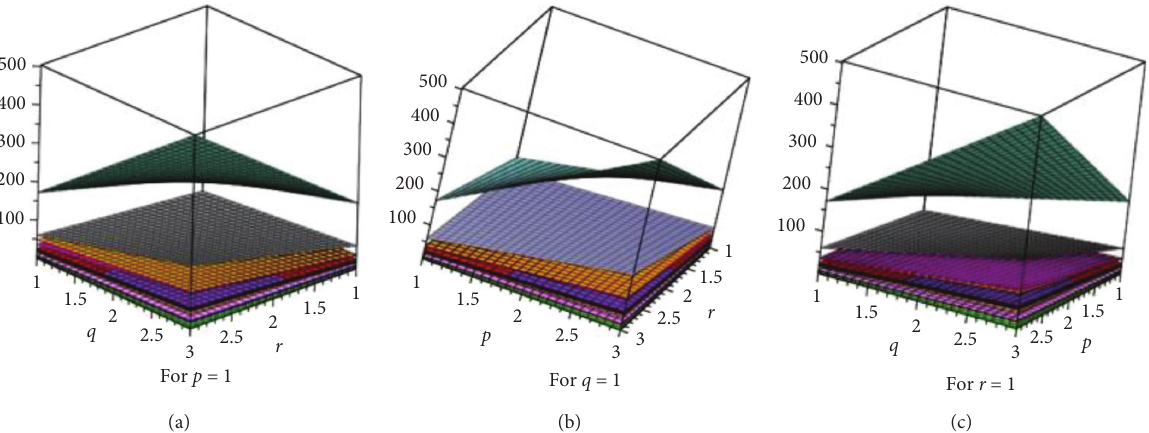
Figure 14: The comparison of all irregularity indices for crystallographic structure Cu